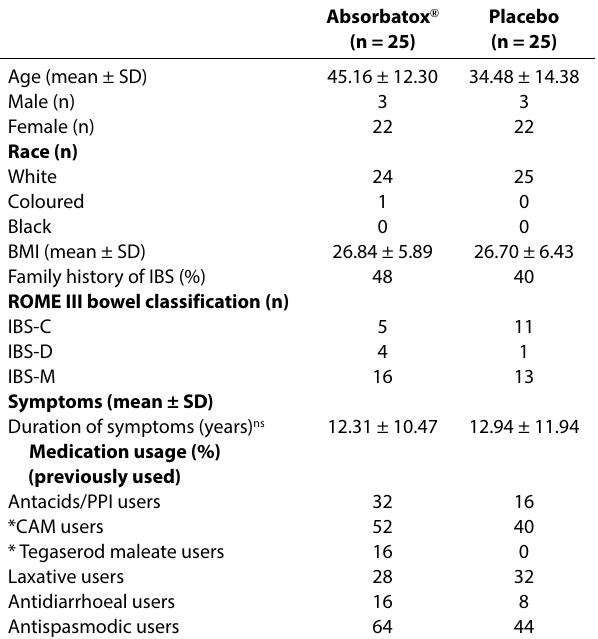
Table 1: Demographic characteristics before